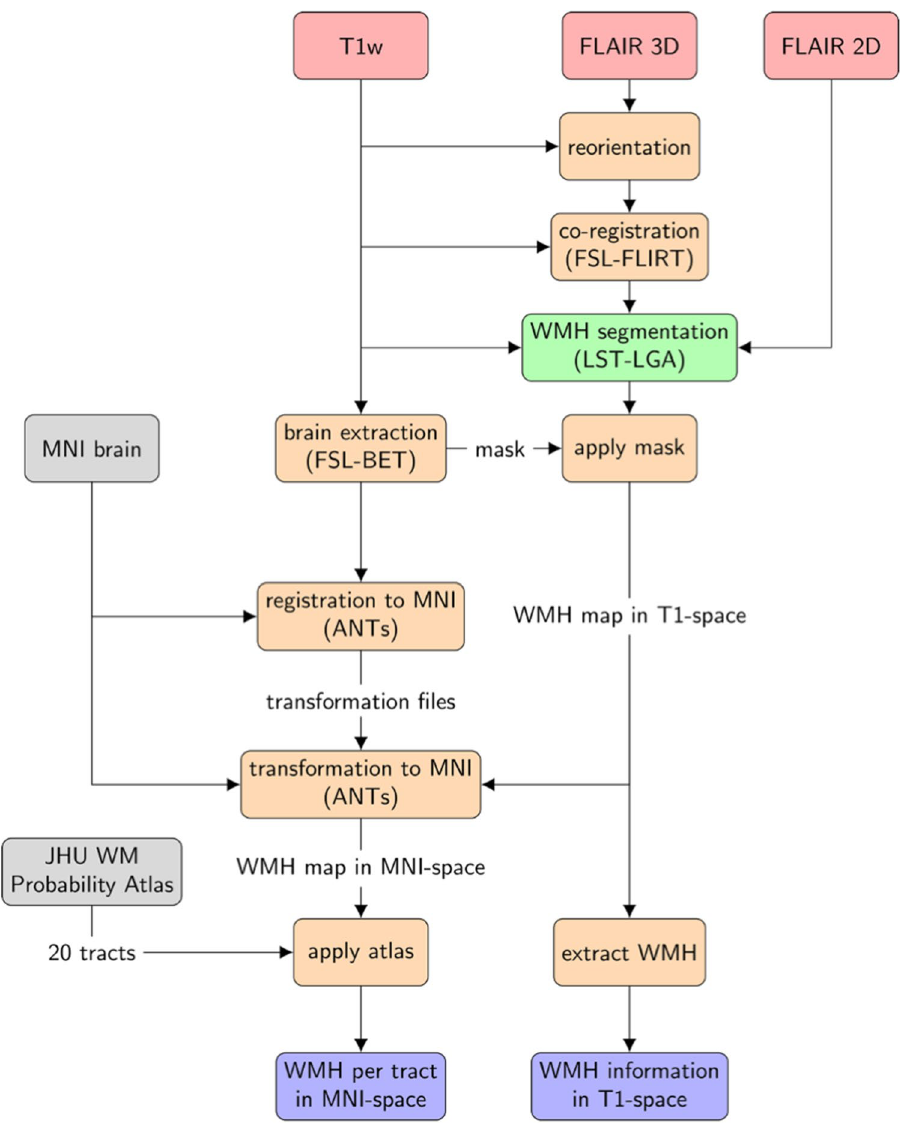
Figure 1. Preprocessing workflow. Workflow of the fully automated approach. 3D-FLAIR images are reoriented and co-registered to the T 1 -weighted (T1w) before WMH segmentation. White matter hyperintensities (WMH) segmentation is performed with the Lesion Segmentation Toolbox-Lesion Growth Algorithm (LST-LGA) using T1w and FLAIR images. The volume and number of WMH are extracted from the WMH maps in T1-space. The WMH probability maps are transformed to Montreal Neurological Institute (MNI) space by applying the transformation from the T1w images. Those maps are masked by the Johns Hopkins University (JHU) white matter (WM) probability atlas to obtain the tract specific WMH volumes. To quantitatively assign WMH to specific WM tracts the probability values of superimposed voxels on the lesion map and the WM tract are multiplied and the resulting product is summed over the entire tract. FLAIR, Fluid-attenuated inversion recovery; FSL, FMRIB Software Library; FLIRT, Linear Image Registration Tool; BET, Brain Extraction Tool; ANTs, Advanced Normalization